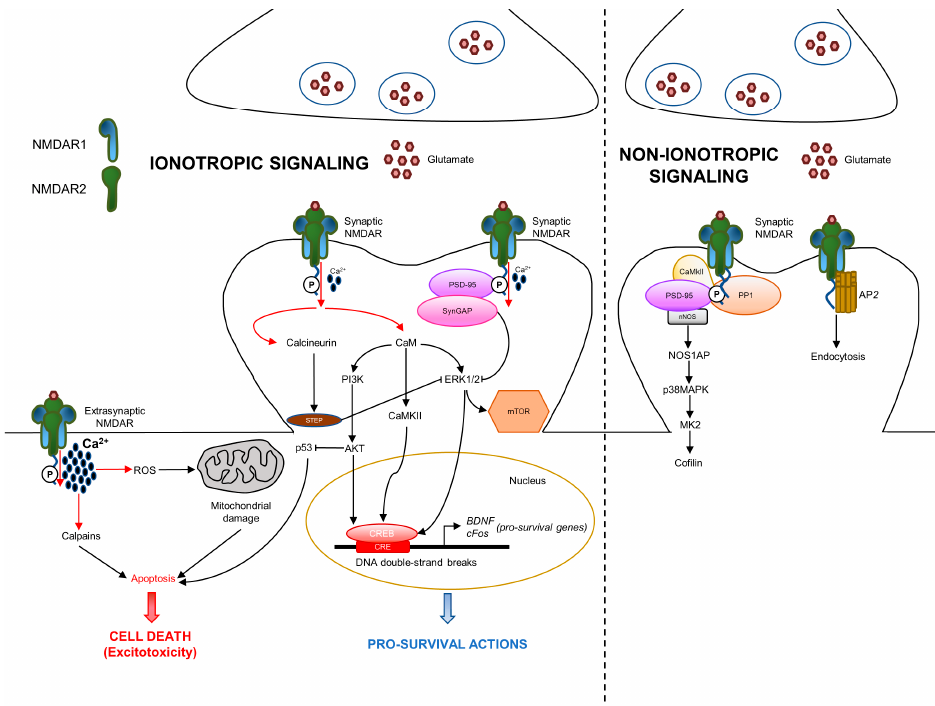
Figure 2. NMDA receptor ionotropic and non-ionotropic pathways in neurons. NMDAR is